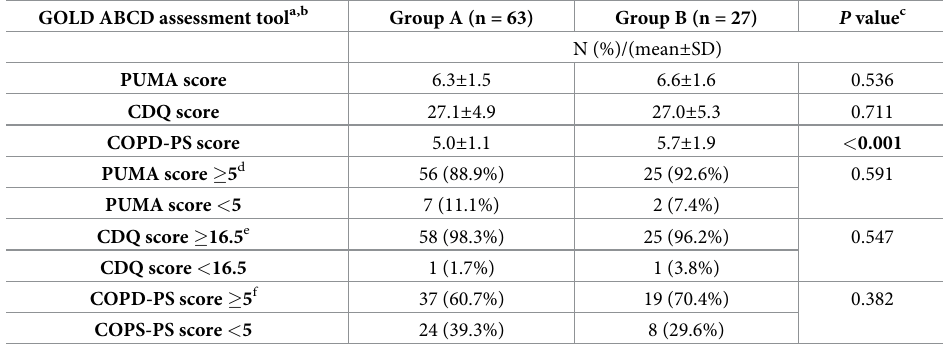
a COPD GOLD ABCD assessment tool [32]: It classifies patients with COPD to one of four groups based on exacerbation history in the past 12 months and CAT score/mMRC scale. b